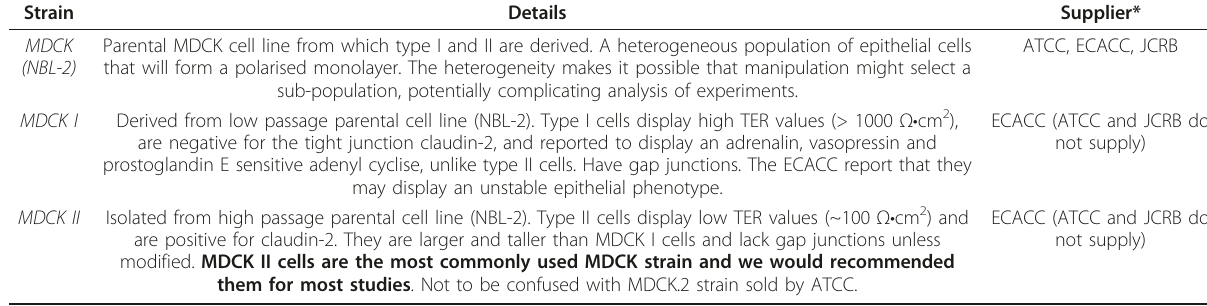
Table 2 The three MDCK strains that are most commonly used to study epithelial cell polarity Strain